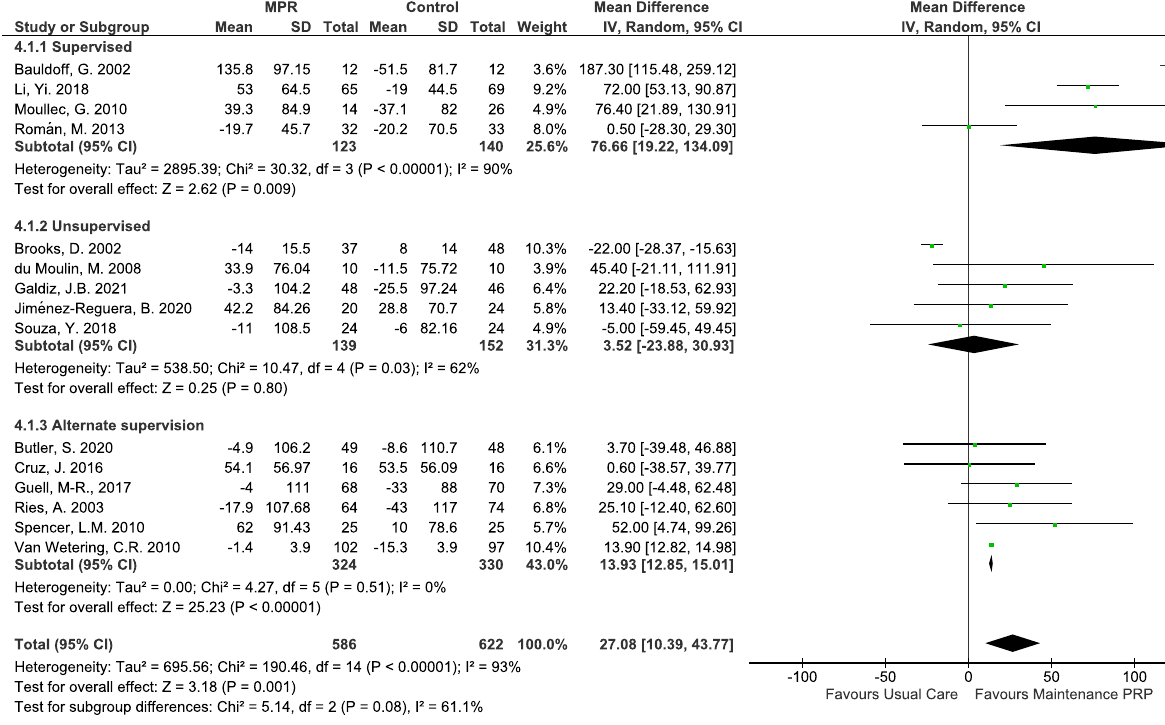
Fig. 3 Forest plot of MD in 6mWT with maintenance PR programme, according to supervision